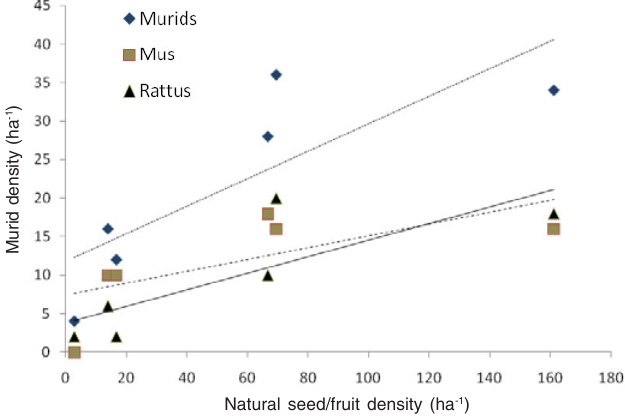
Figure 1. Relationship between seed/fruit density on the forest floor and densities of M. mayori (solid squares), R. r. kandianus (solid triangles) and total murids (solid diamonds).